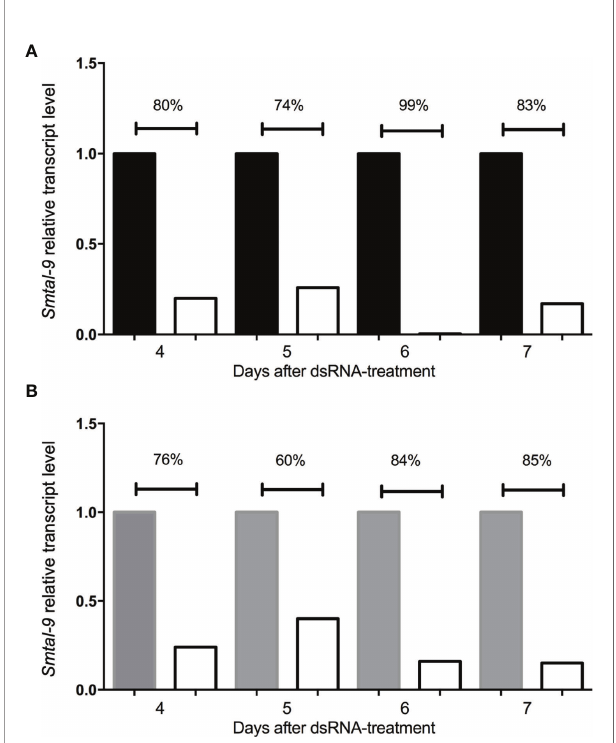
FIGURE 1 | Kinetics of smtal – 9 transcript levels after schistosomula dsRNA exposure for 7 days. Graphical depiction of the relative smtal – 9 transcript levels and their comparison between smtal – 9 dsRNA (white bars in both charts) exposed schistosomula and two different control groups: untreated parasites (black bars in A ) or parasites treated with gfp – speci fi c dsRNA (grey bars in B ). Transcripts were evaluated between the fourth to the seventh day after dsRNA exposure. Transcript levels of smtal – 9 were evaluated by RT – qPCR. Percentage of reduction of the smtal – 9 transcript levels in s mtal – 9 – dsRNA treated parasites was calculated in comparison to the transcript level observed in untreated (A) or gfp – dsRNA (B) treated